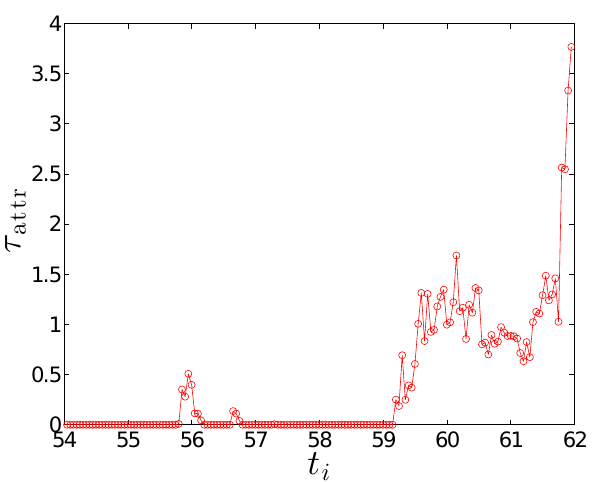
Fig. 6. Distance between analysis and the attractor as measured by τ attr . Parameters as in Fig. 1.